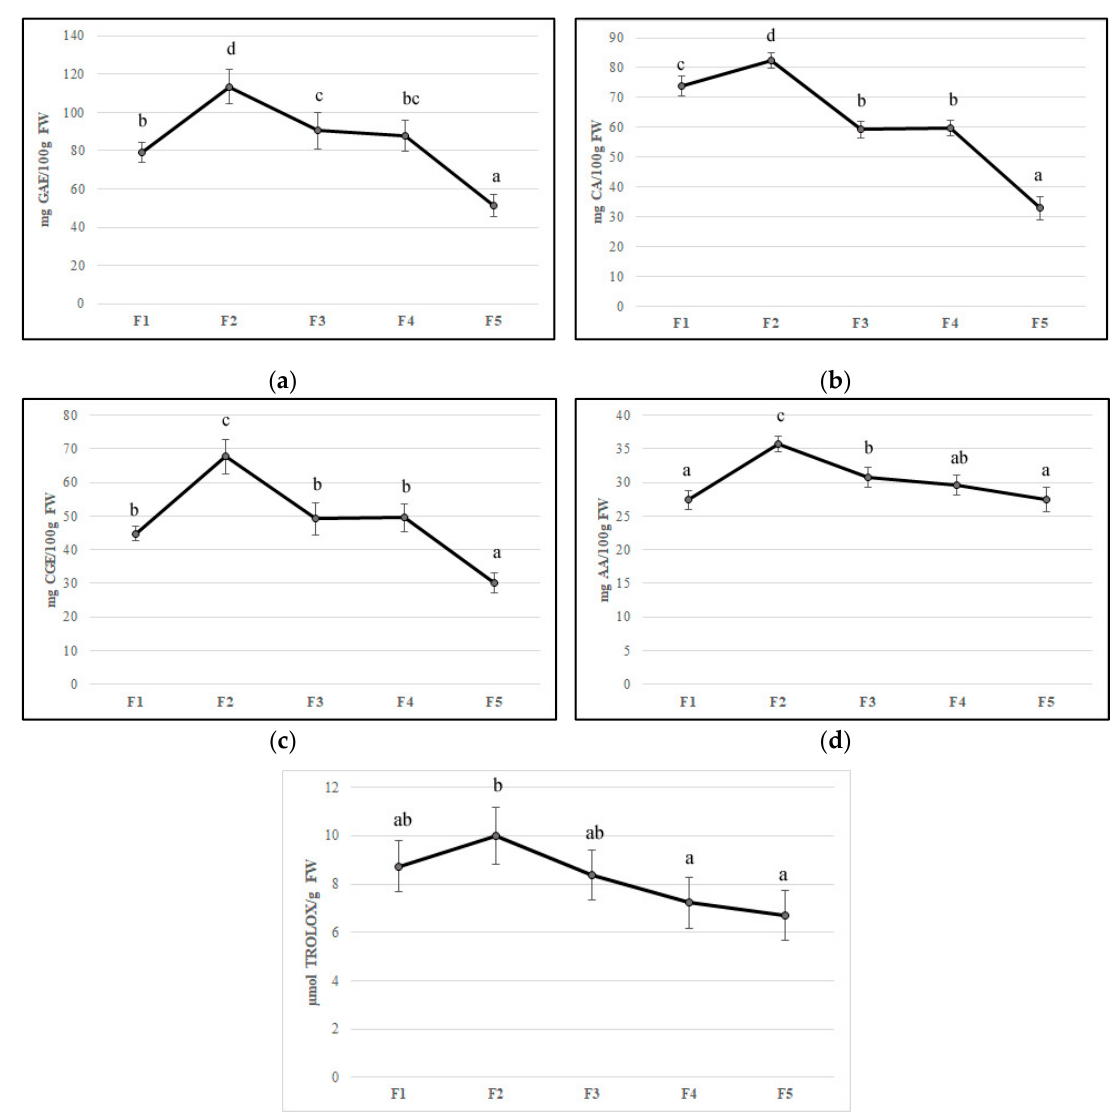
Figure 2. Bioactive compounds content ( a ) polyphenols, ( b ) flavonoids, ( c ) anthocyanins, ( d ) ascorbic acid, and ( e ) antioxidant activity in five different flowering stage of feijoa (F1, F2, F3, F4, F5). Means followed by the same letter do not differ significantly at P = 0.05 (Duncan Test).